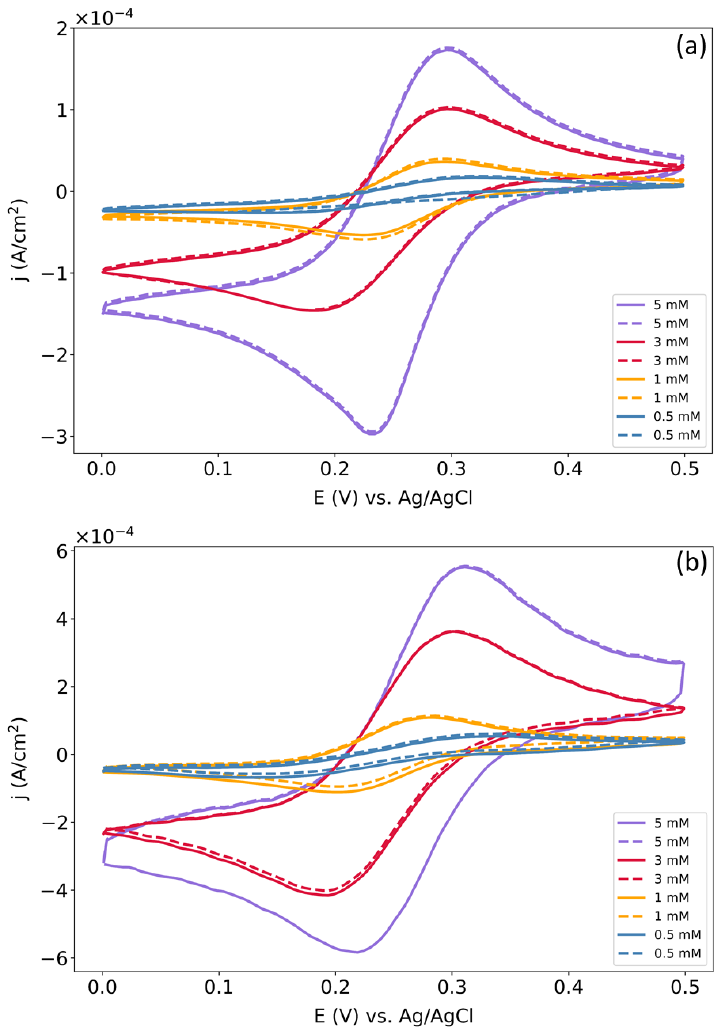
Figure 6. Experimental cyclic voltammogram obtained using Au stripes on chip as working elec- trodes (solid curve), at a scan rate of ( a ) 10 mV/s and ( b ) 100 mV/s, compared to the computed voltammograms (dashed curves). The concentration of potassium ferricyanide (redox species) was set to 0.5, 1, 3, and 5 mM, as labelled in the legend, in 100 mM of potassium nitrate as the electrolyte.